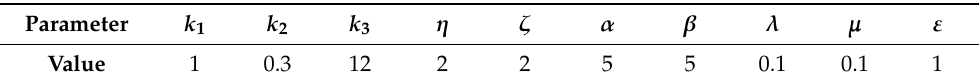
Table 2. Parameters of the controllers.